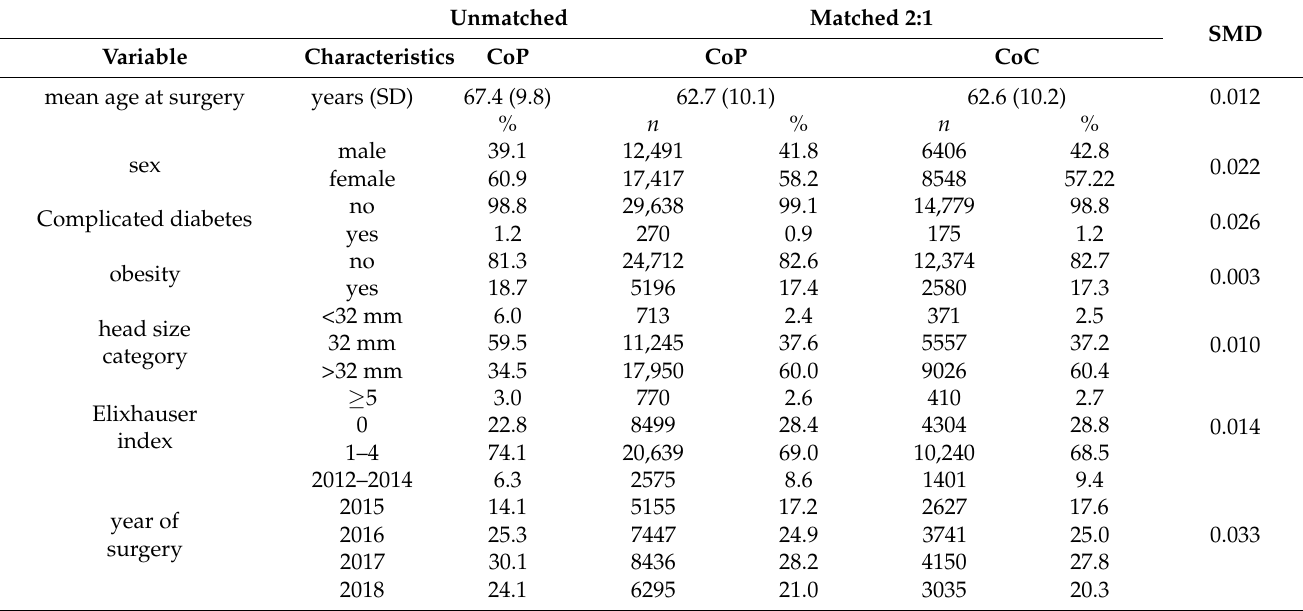
Table 1. Description of categorical variables stratified by bearing type before and after 1:2 matching, with standardized mean differences (SMD) indicating balance of the matched groups.